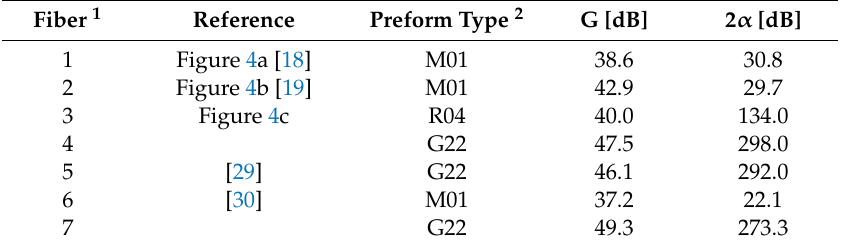
Table 2. Scattering parameters and fiber characteristics of MgO-NP specialty fibers.